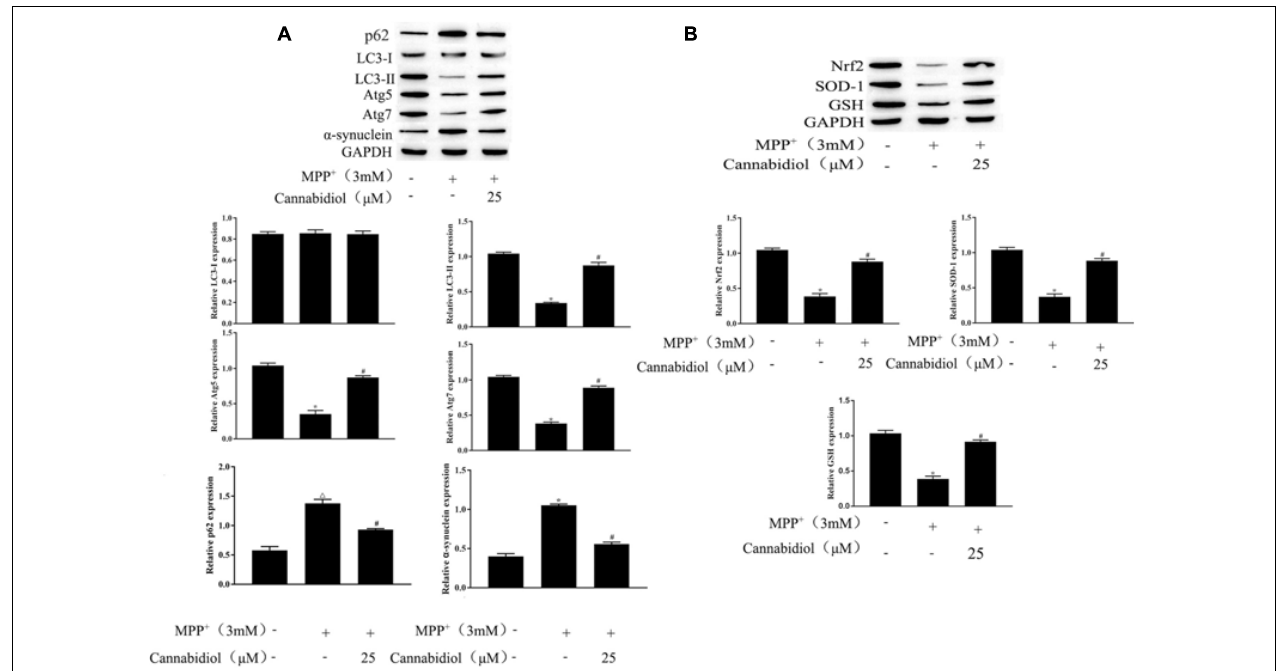
FIGURE 3 | Cannabidiol alleviated mitochondrial dysfunction in MPP + -induced SH-SY5Y cells. (A,B) The expression of autophagy-related proteins and antioxidant proteins in SH-SY5Y cells were measured by western blotting; * p < 0.05, compared with control group, # p < 0.05 compared with MPP +